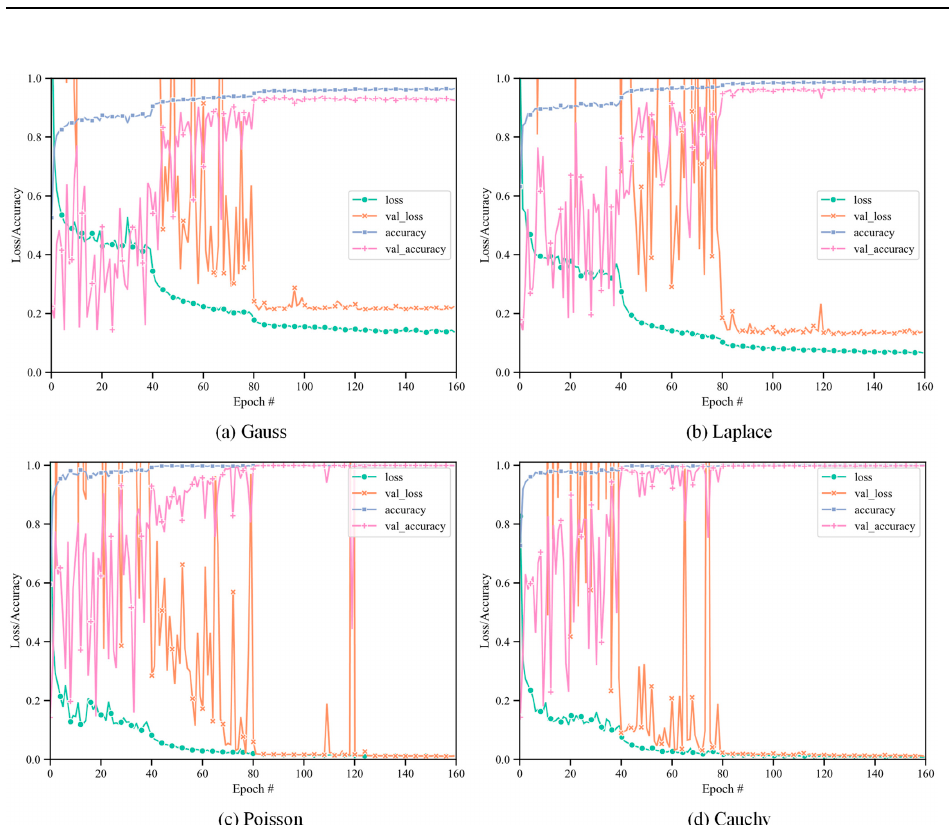
Figure 5. Training processing under four types of noise.